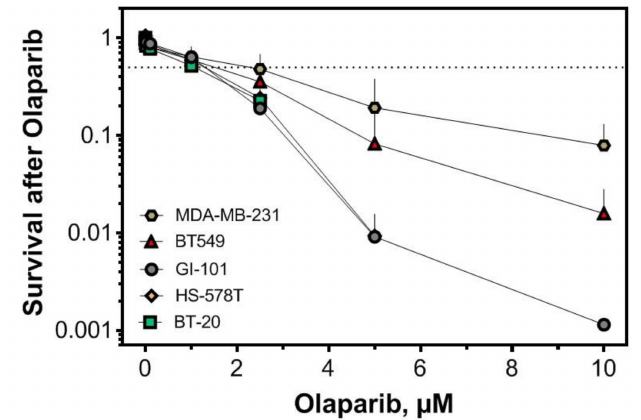
Figure 4. Cellular sensitivity of TNBC to PARP1 inhibition. Colony-forming assays were performed after treatment, with increasing concentrations of the PARP1 inhibitor Olaparib for 90 min. Each value represents the mean of at least three independent experiments, with SEM indicated.